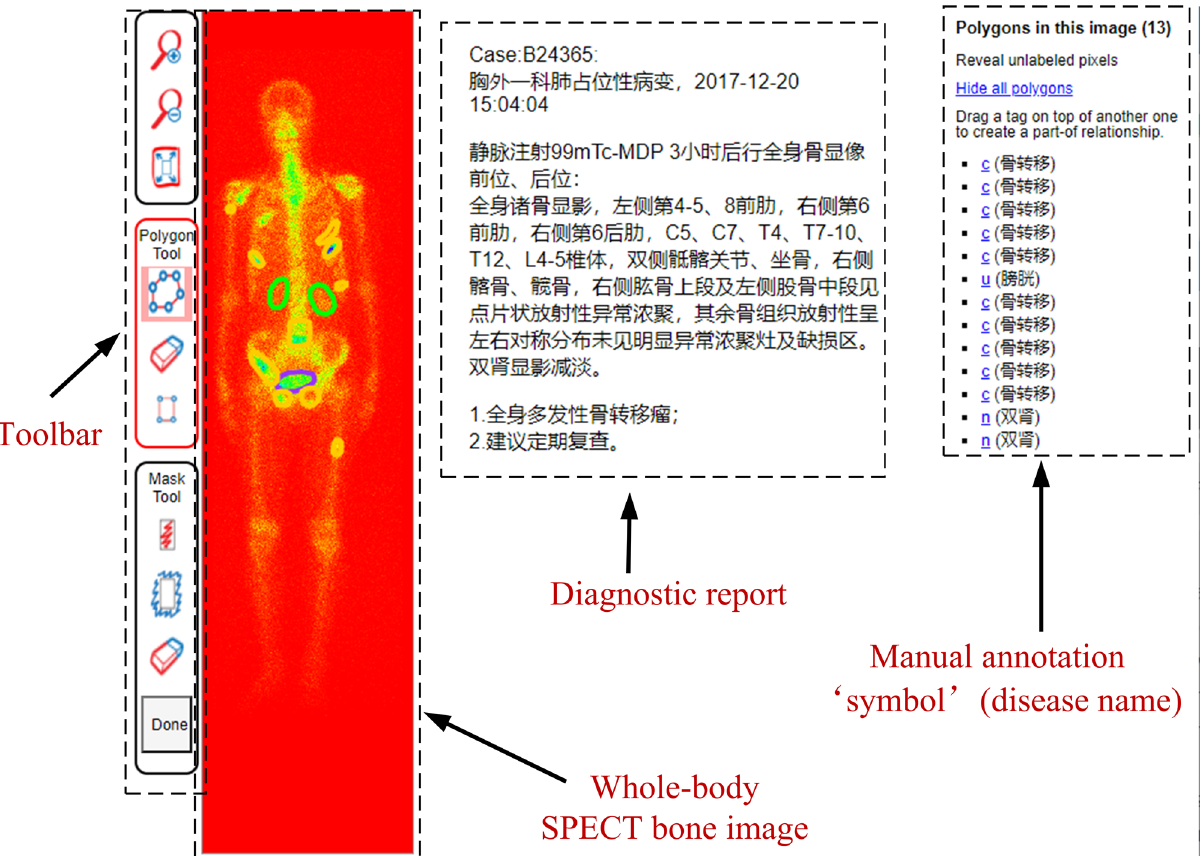
Figure 5. Labelling whole-body SPECT bone image using LabelMe (version 3.0, http://label me2.csail .mit.edu/ Relea se3.0/brows erToo ls/php/sourc ecode .php) based annotation